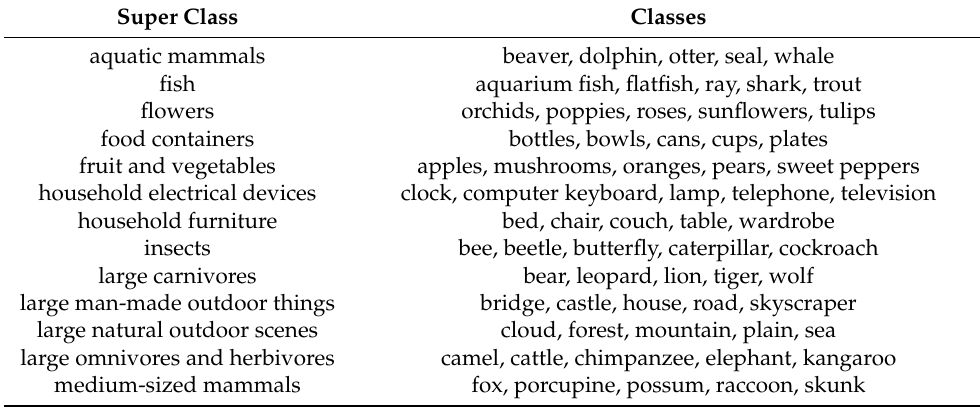
Table 1. The labels of